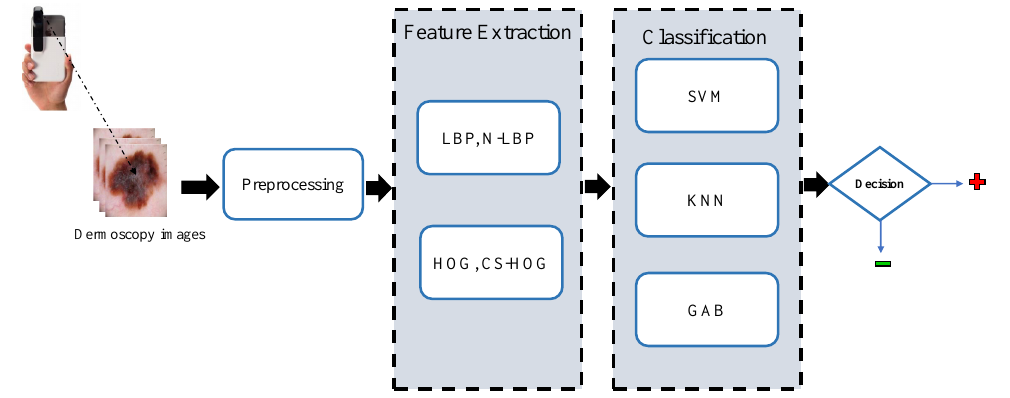
Figure 1. Block diagram of the proposed CAD system for skin